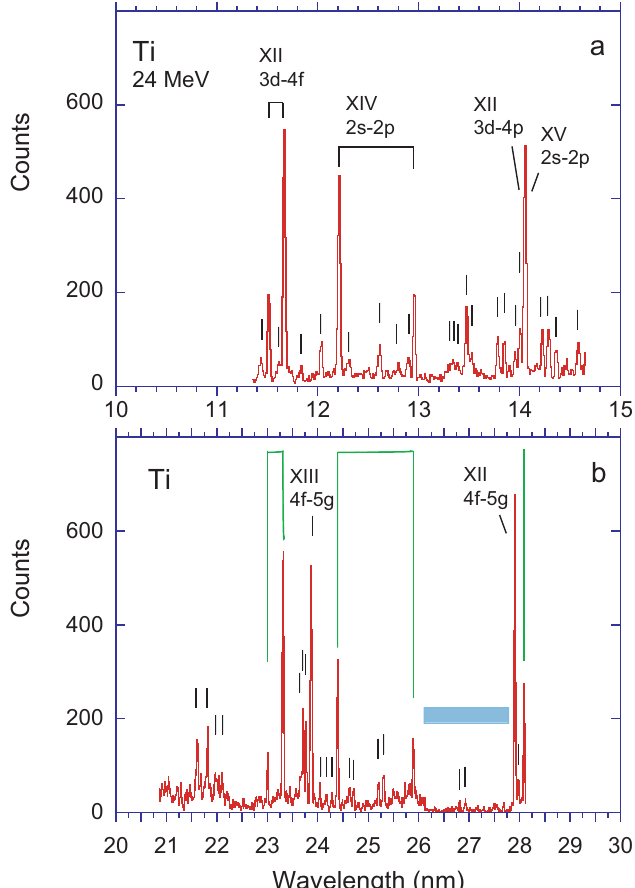
Figure 3. Beam–foil spectra of Ti at an ion beam energy of 24 MeV. Grating 600 L/mm, line width (FWHM) 0.03 nm. The strongest lines are identified by the spectrum number. Unidentified lines are marked by a fiducial. ( a ) Observation of the wavelength range 11.4 nm to 14.6 nm; ( b ) observation of the wavelength range 21 nm to 28 nm, that is, including the second diffraction order image of the spectrum in ( a ). The light blue horizontal bar marks a range of data recording with a reduced ion beam charge preset per channel (see the